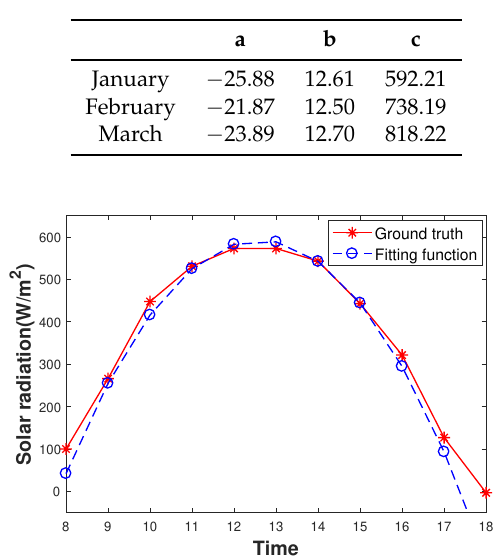
Figure 6. Fitting curve of the Weather Forecast (WF).